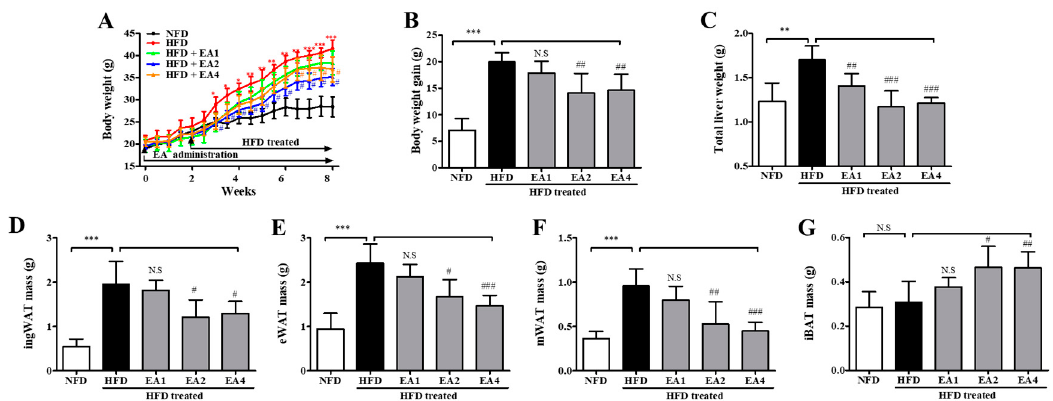
Figure 10. The body and adipose tissue weight changes in mice fed an NFD or an HFD and mice fed an HFD and pretreated with ellagic acid at a dosage of 1, 2, or 4 mg/kg/day. ( A ) Body weights were measured three times per week for 8 weeks. ( B ) Gained body weight, ( C ) total liver weight, ( D ) inguinal white adipose tissue weight, ( E ) epididymal white adipose tissue weight, ( F ) mesenteric white adipose tissue weight, and ( G ) interscapular brown adipose tissue weight. The results are presented as the mean ± SD (n = 8). * p < 0.05, ** p < 0.01 and *** p < 0.001 vs. NFD group; # p < 0.05, ## p < 0.01 and ### p < 0.001 vs. HFD group. N.S, not significant.